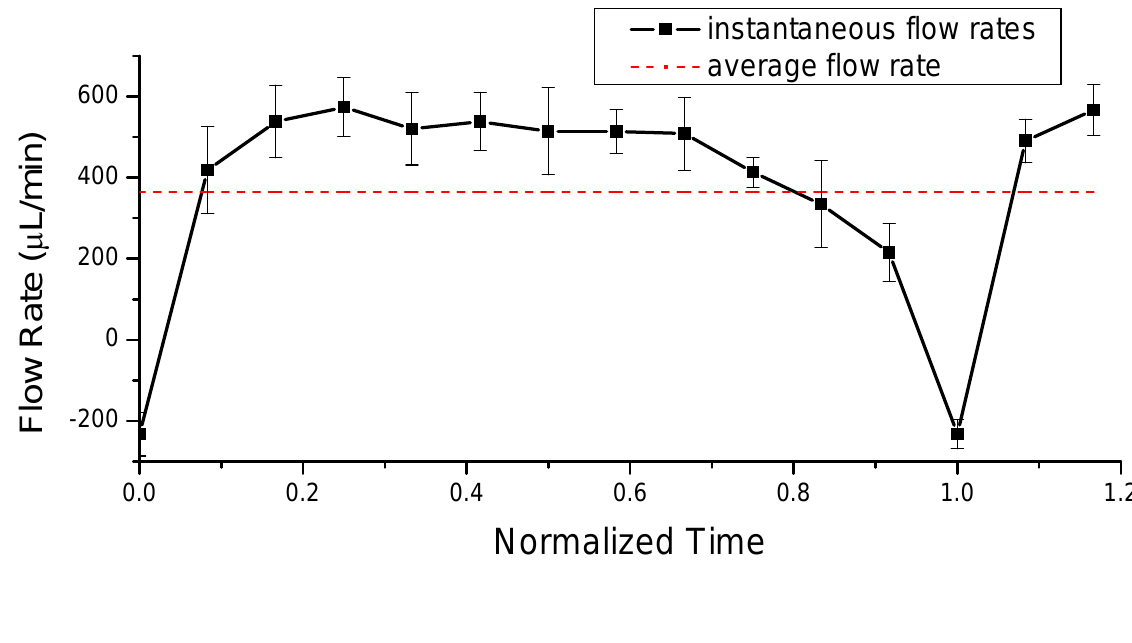
Figure 8. Flow rate during a pumping cycle. The X-axis represents the normalized time of a pumping cycle (time divided by the pumping period), at 40 rpm, 0.5 s pumping period. The data is based on the average of three measurements. The red dashed line represents the average flow rate with the same condition as shown in Figure